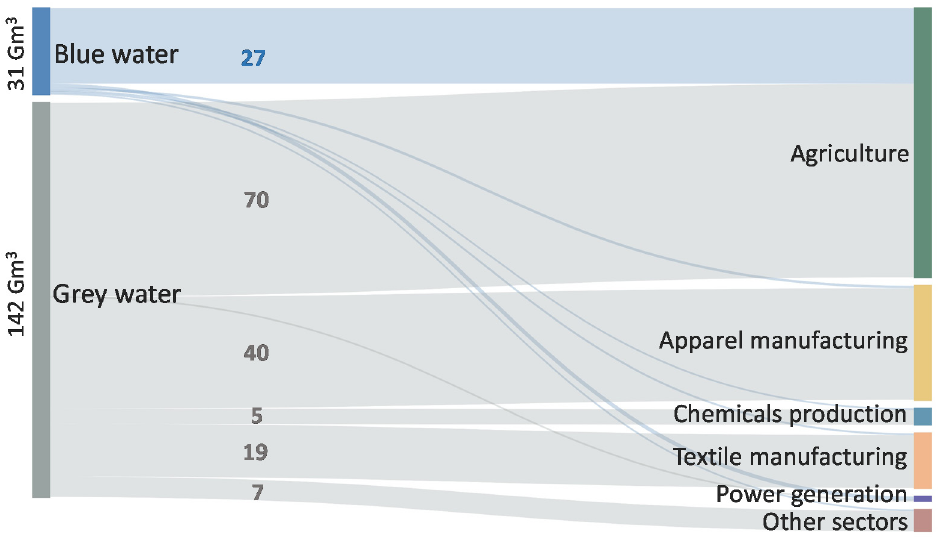
Figure 1. The sector-wise blue and grey water use in the supply chain of China’s apparel manufac- turing in 2015.